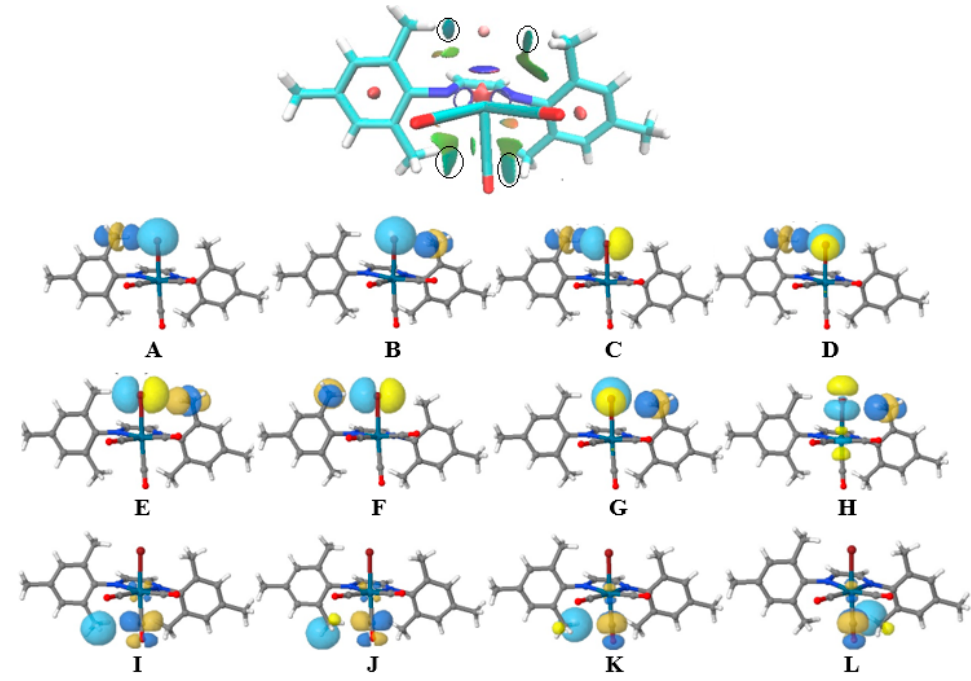
Figure 6. NCI plot of 3 and the representation of interacting donor–acceptor n s (Br) ... σ *(CH), A – B ; n p (Br) ... σ *(CH), C – H ; σ (CH) ... π *(CO), I – L ; orbitals from NBO calculations.